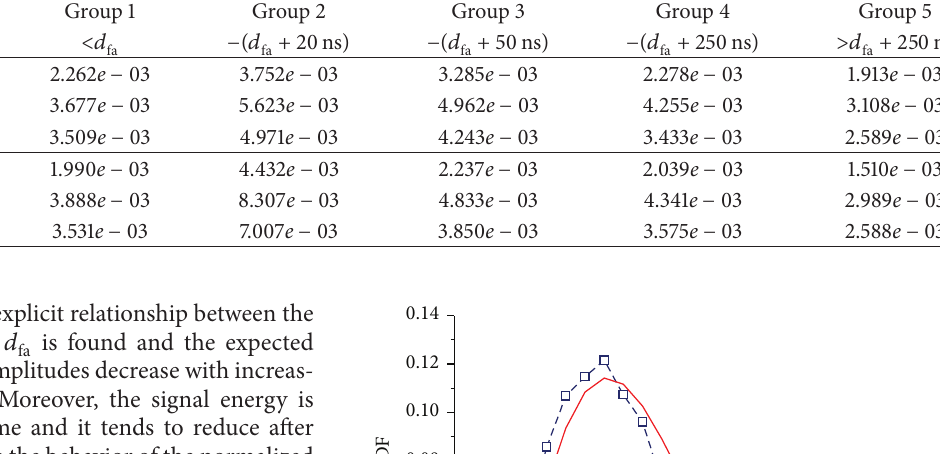
Table 3: The normalized 𝑎 𝑘 , the parameters of the fitted Rayleigh distributions in two scenarios. Scenario